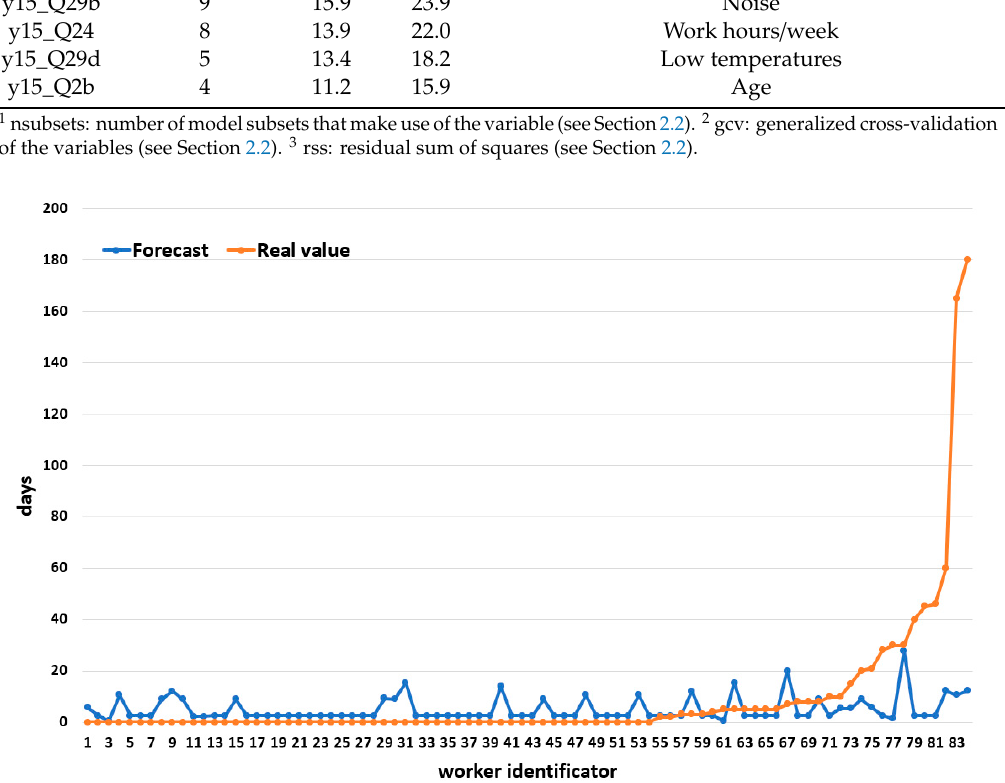
Figure 4. Results of one of the models created: forecasted and real number of days off for all the workers randomly included in the validation dataset. Table 5. A list of variables selected by the model as the most relevant to predict absenteeism among workers in the energy sector.